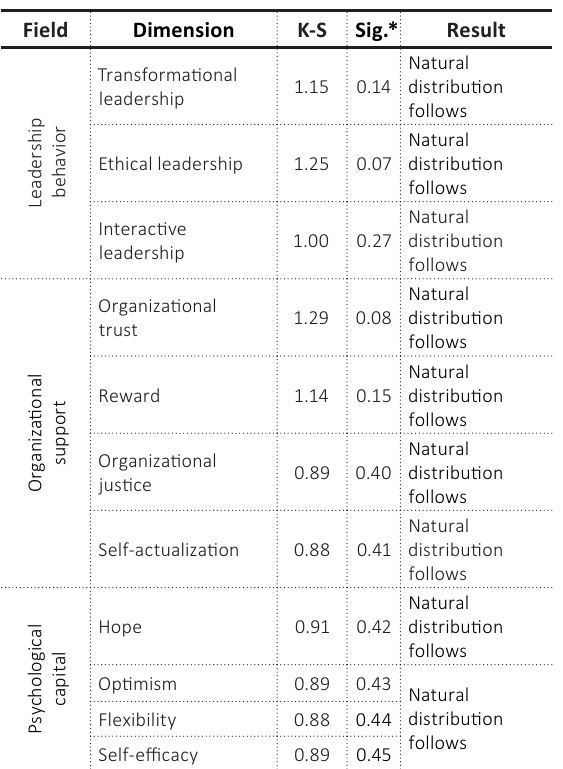
Table 3. Normal distribution of study variables (K-S test)